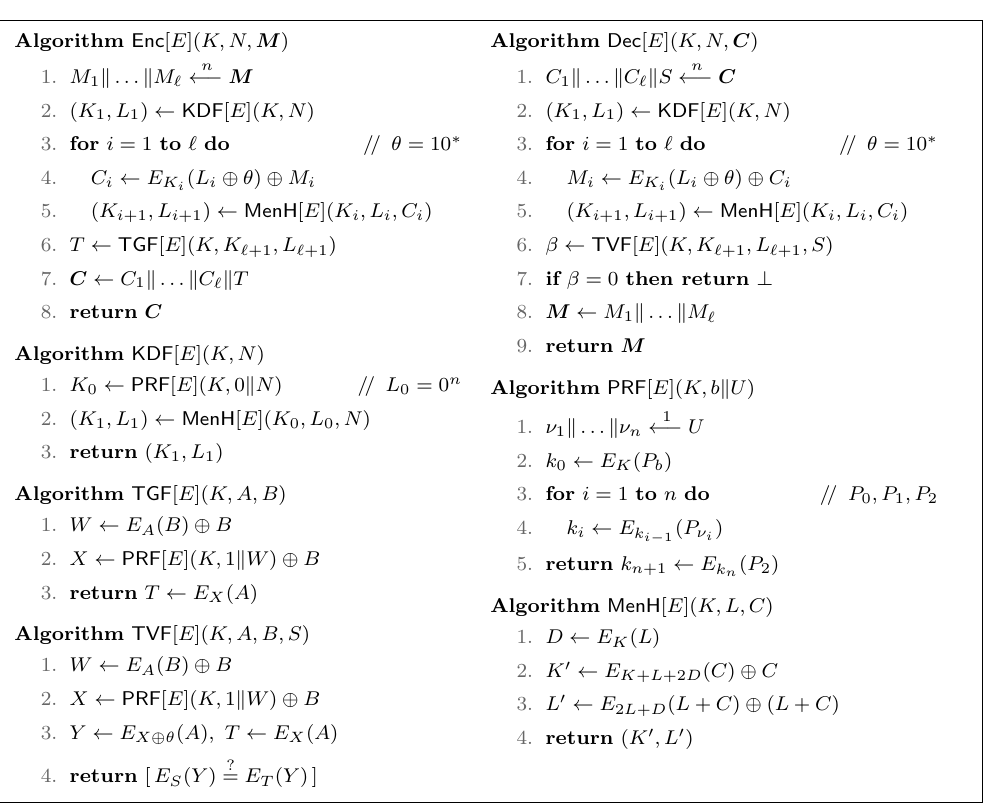
Figure 11: Definition of the LR-BC-2 mode, using a BC E